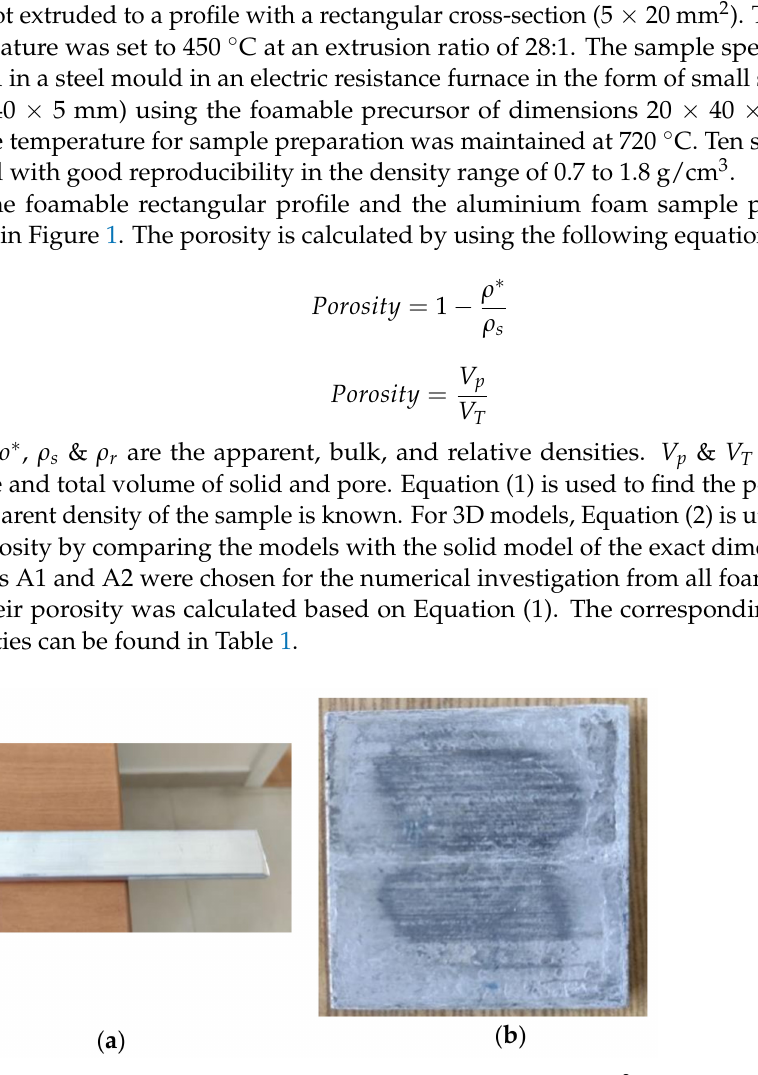
Figure 1. ( a ) Foamable rectangular profile of cross-section (5 × 20 mm 2 ) and ( b ) Aluminium foam sample prepared (40 × 40 × 5